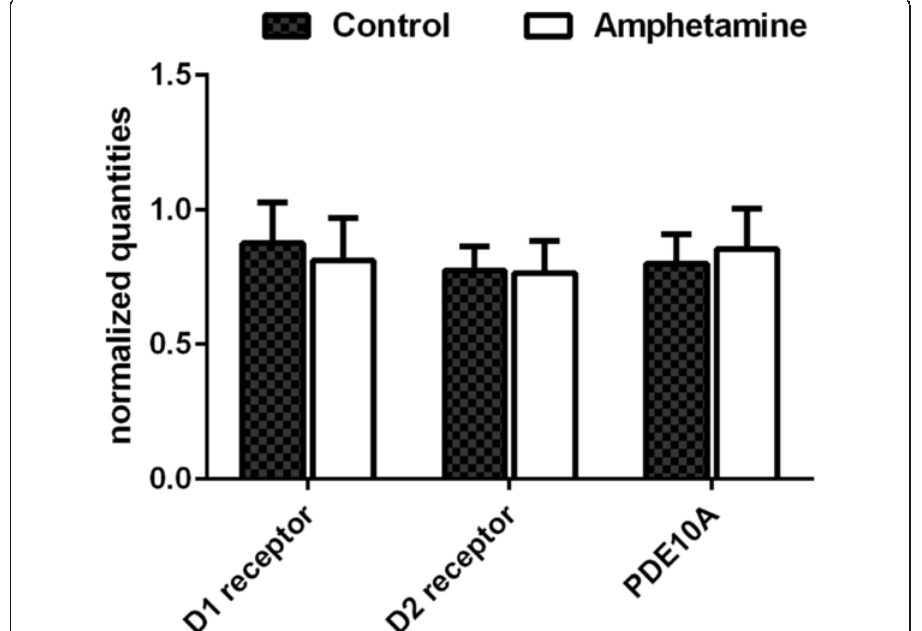
Fig. 6 mRNA quantification in amphetamine and saline treated animals. Normalized quantities for D 1 , D 2 and PDE10A acquired in amphetamine and saline treated. GUSB and HMBS were used for the normalization of quantities values. Data are presented as mean±SD. No significant difference in mRNA levels of amphetamine and saline treated animals could be